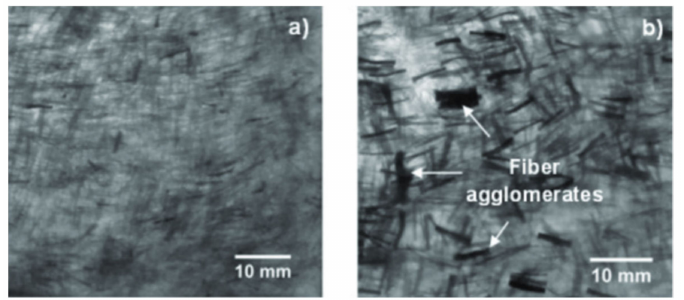
Figure 9. TEM images of 8 wt% of nanocellulose from pineapple leaf; ( a ) raw and ( b ) treated fibers, reinforced in PP composite. Reproduced with permission from [69]. Copyright 2016